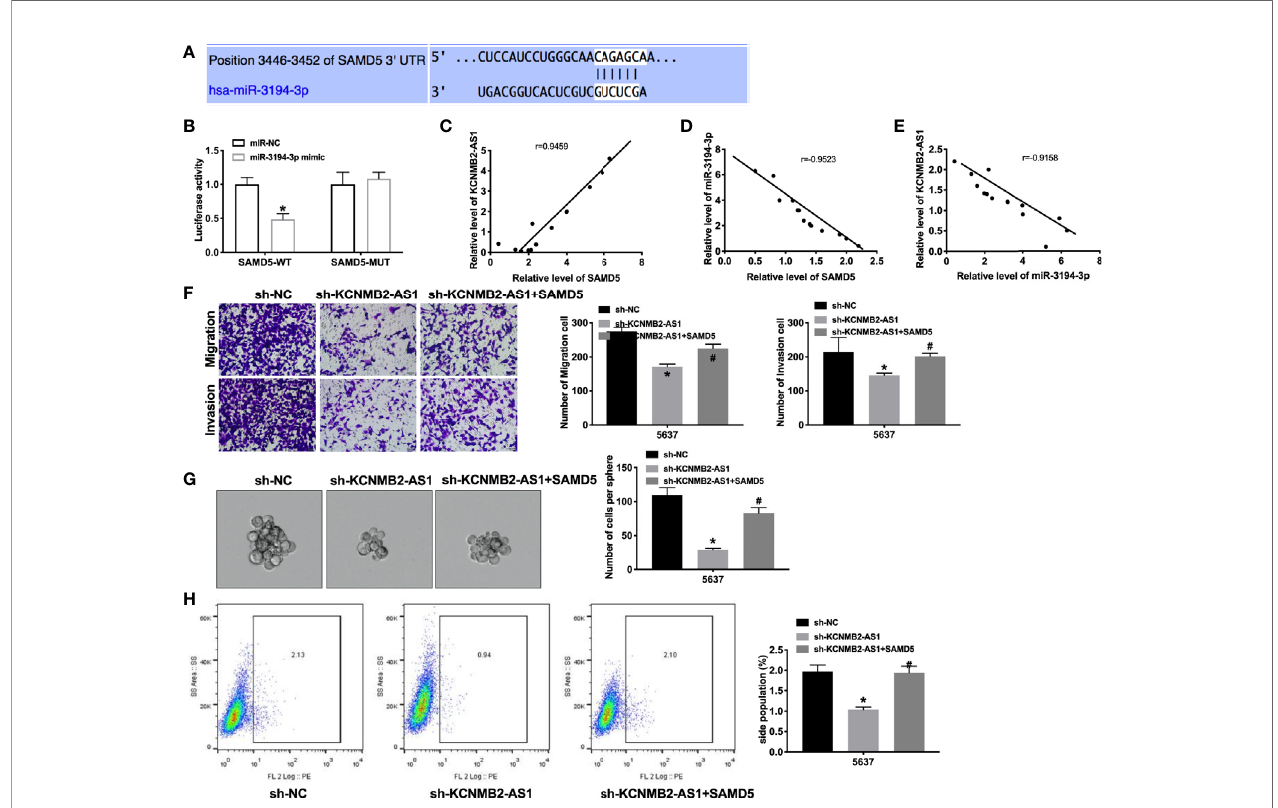
FIGURE 5 | SAMD5 is a target of miR-3194-3p. (A) miRNA binding sites prediction of SAMD5. (B) The activity of luciferase was measured. n = 3. (C) The correlation between KCNMB2-AS1 and SMAD5 expression. n = 14. (D) The correlation between SAMD5 and miR-3194-3p expression. n = 14. (E) The correlation between KCNMB2-AS1 and miR-3194-3p expression. n = 14. (F) Detecting cell migration and invasion by Transwell invasion assay. n = 5. (G) Tumor sphere- forming ability was assessed. n = 5. (H) The side population of bladder cells was determined by fl ow cytometry. n = 5. * P < 0.05, # P <